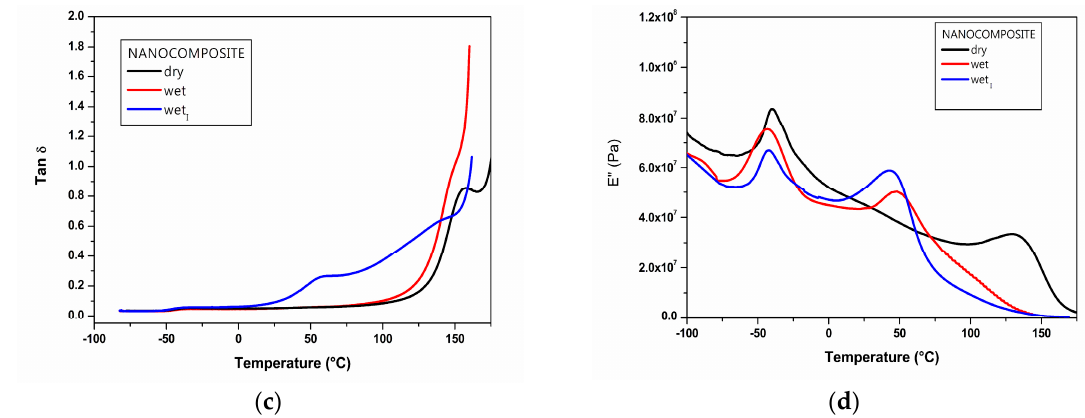
Figure 11. Dynamic-mechanical spectra in terms of loss factor (tan δ ) ( a , c ) and loss modulus (E ″ ) ( b , d ) at 1 Hz for dry, wet and wet I samples of plain poly(carbonate urethane) and TiO 2 /poly (carbonate urethane) nanocomposite. Table 3. Tg values for dry, wet and wet I samples of plain PU and its nanocomposite.